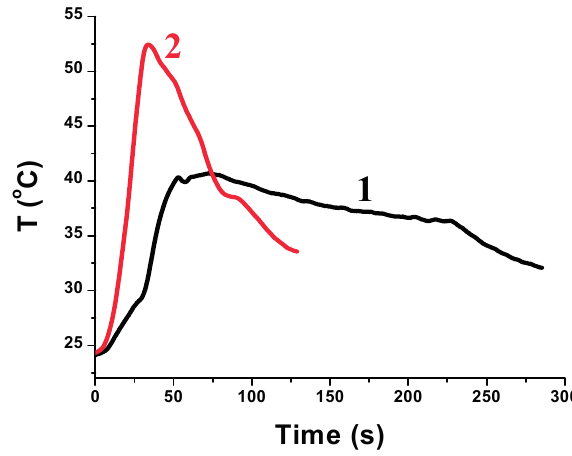
Figure 2. Comparison of the polymerization initiating ability under air and at RT of sample containing 1% (wt) of AgSbF 6 and 2% (wt) of DPSi in TMPTA: ( 1 ) without NVK and ( 2 ) with 2% (wt) of